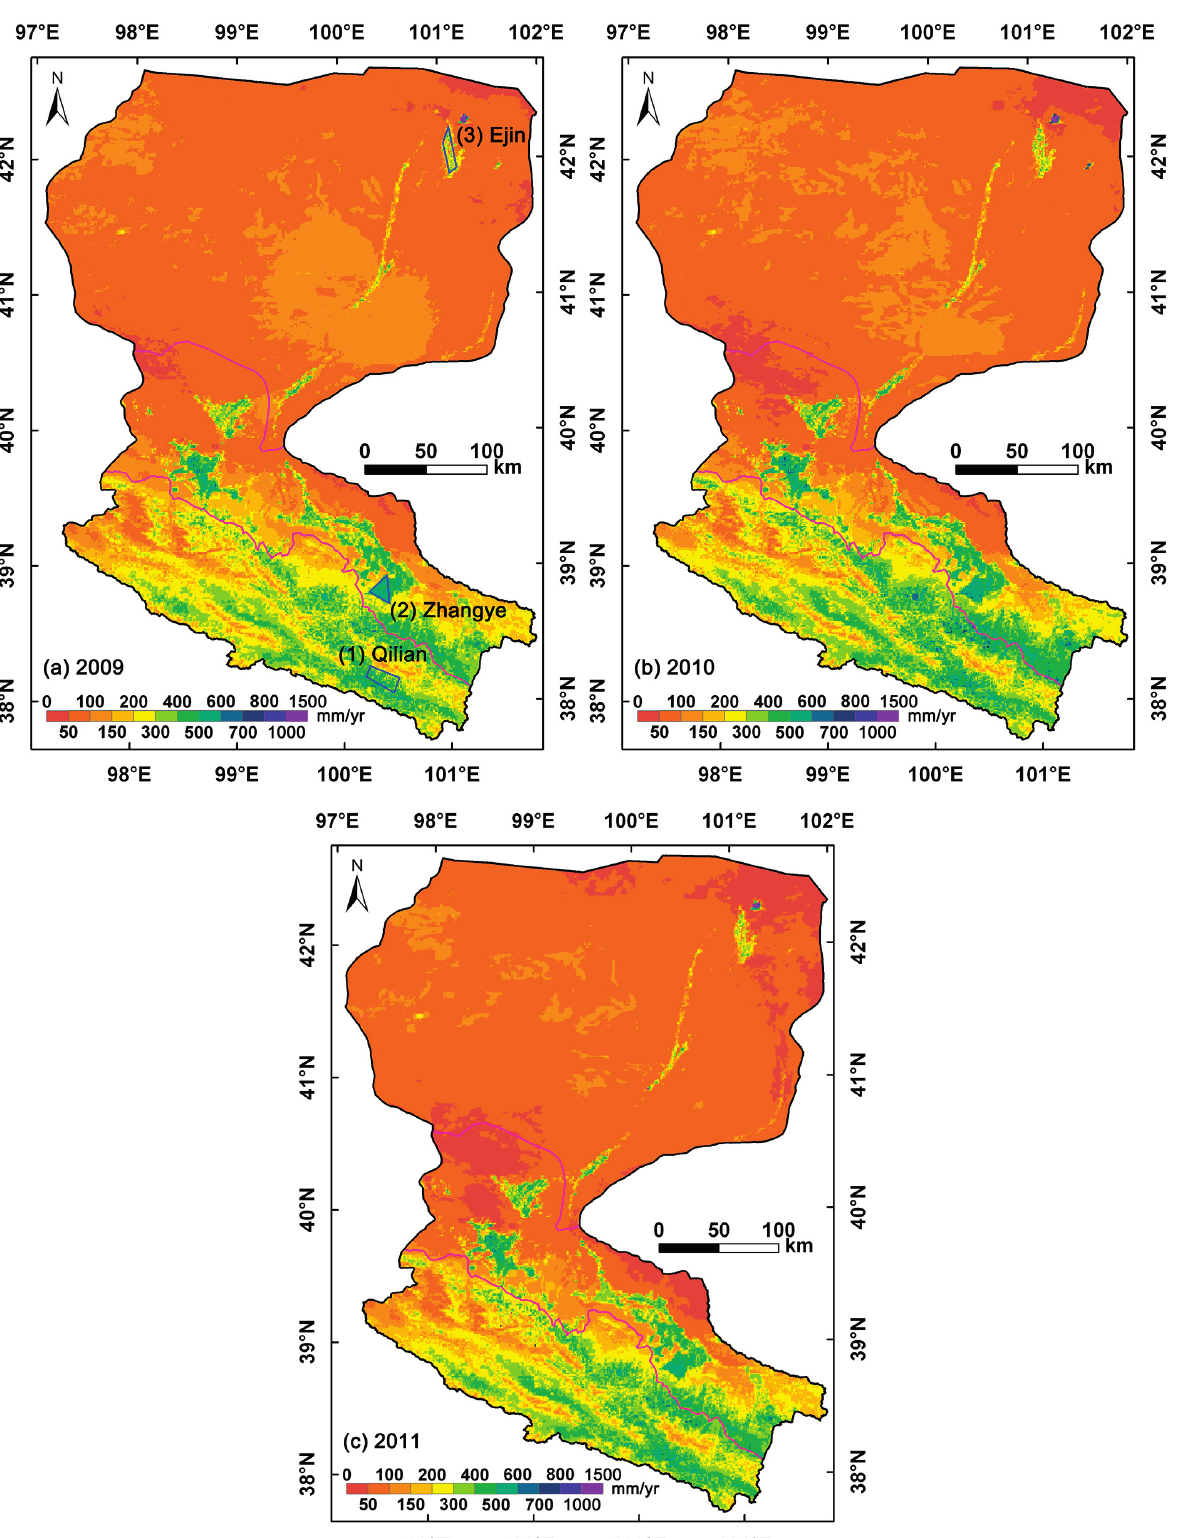
Figure 8. Spatial patterns of the annual ETa spanning 2009–2011 ( a – c ) in the Heihe River basin with the maximum ETa of 1400 mm/year at the terminal